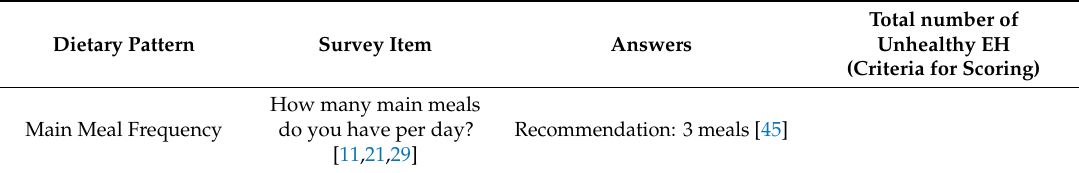
Table A1. Estimation of nutrition and related